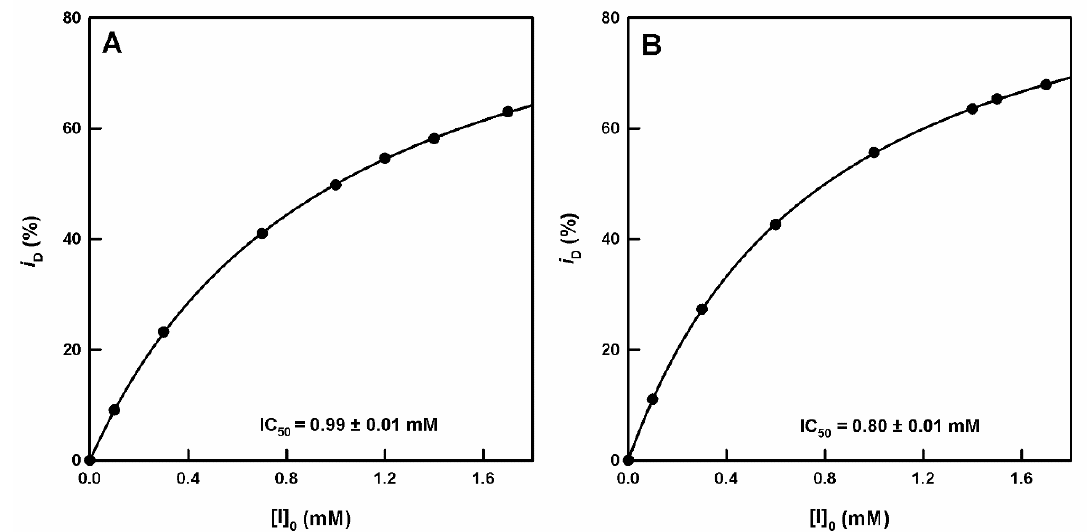
Figure 1. Representation of the i D (degree of inhibition of diphenolase activity) values, calculated from the experimental values of V D,DC (initial rate of dopachrome accumulation when the enzyme 0 acts on L-dopa) and V D,DC (initial rate of dopachrome accumulation when the enzyme acts on L-dopa o,i in the presence of inhibitor), with respect to the inhibitor concentration. ( A ). Representation of i D